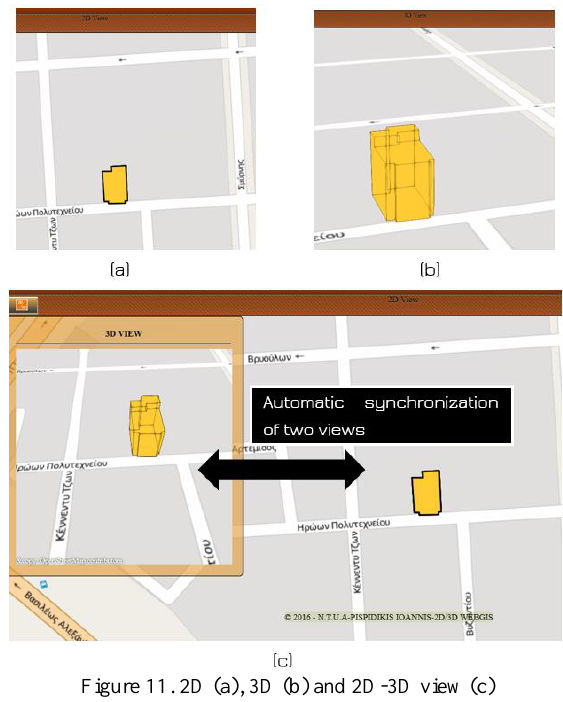
Figure 11. 2D (a), 3D (b) and 2D-3D view (c)